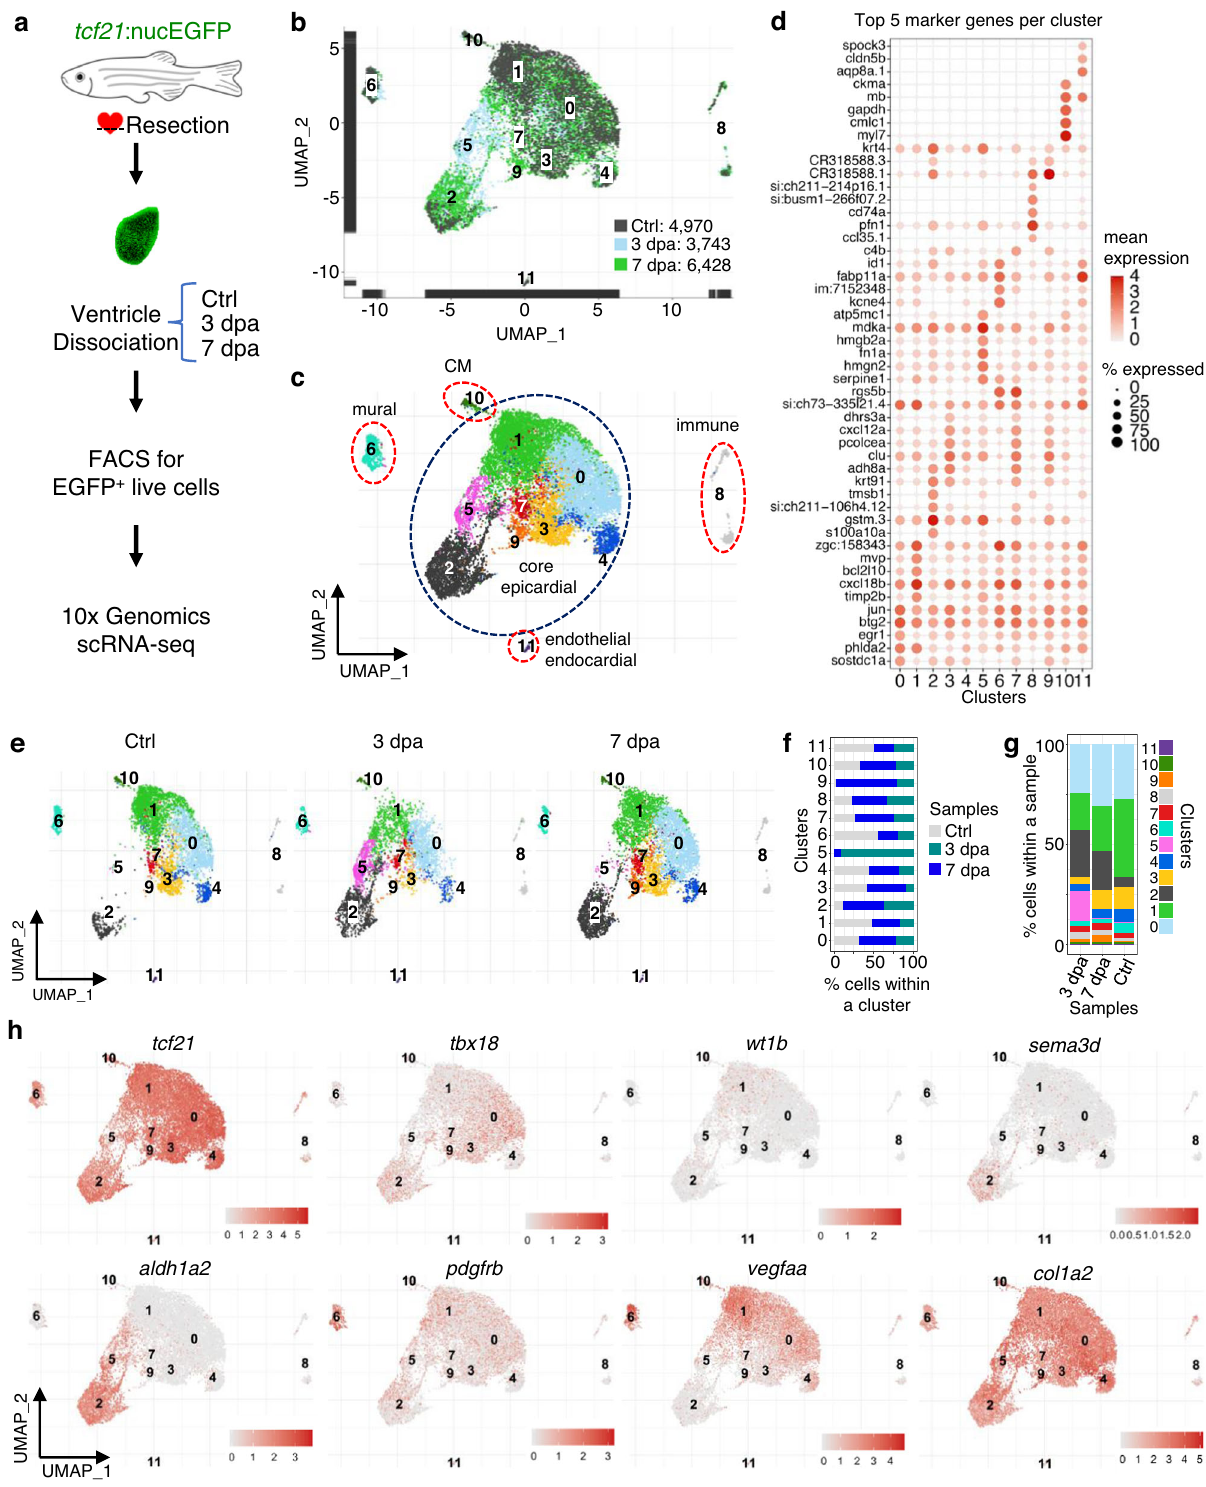
Fig. 2 | ScRNA-seq reveals distinct subsets of the ventricular epicardial lineage during heart regeneration. a Experimental design for single epicardial cell isola- tion and transcriptome sequencing. b UMAP of three samples combined. After the removalofdropletswithveryfewgenesaswellasgenesthatcouldnotbedetected in at least 5 cells, the fi nal dataset comprised 4970, 3743, and 6428 cells for Ctrl, 3dpa, and 7dpa, respectively. c UMAP of cell clusters with inferred cellular